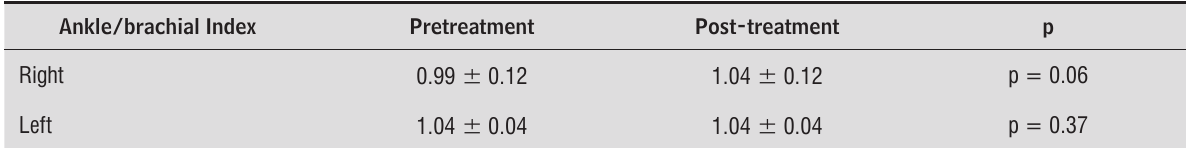
Table 2 - Mean±Standard Deviation of ankle/brachial index pretreatment and